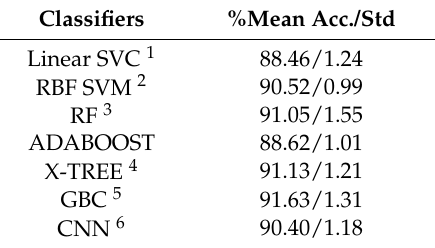
Table 3. B. oleae verification